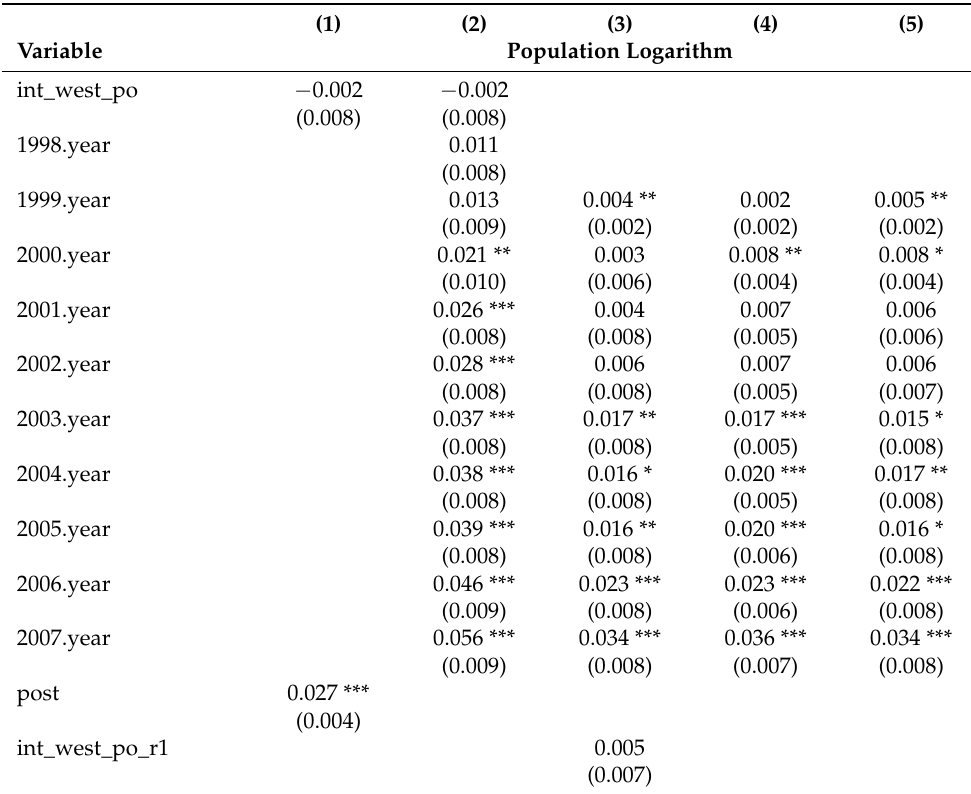
Table A2. Western Development and